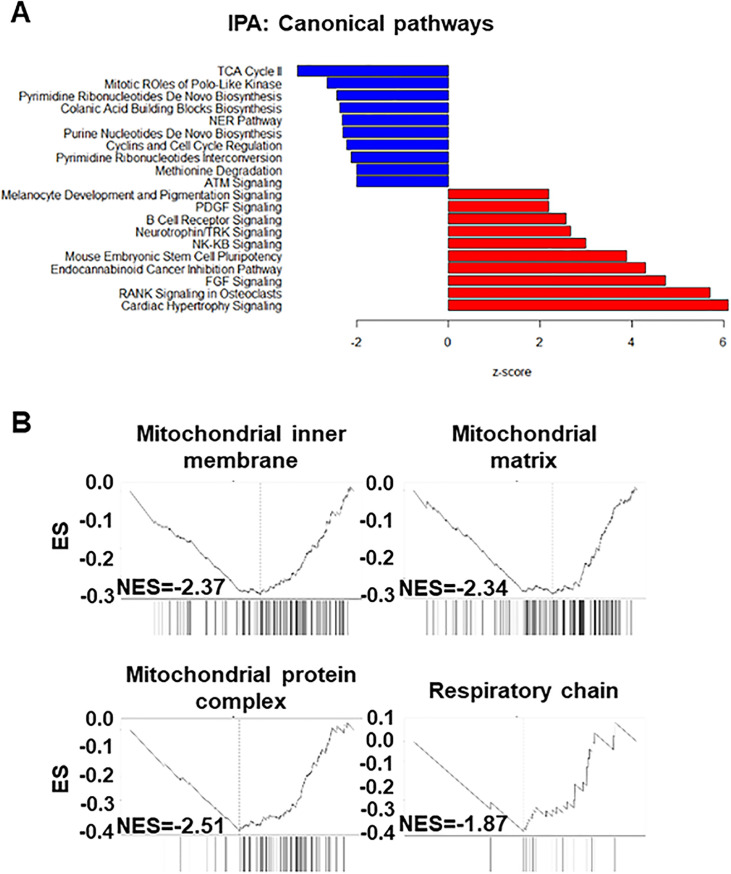
RNA-seq data indicate that EtOH may alter mitochondria-associated gene expression.EPC1, EPC2 and EPC3 cells were treated with or without EtOH (2%, 8 h) and subjected to RNA-Seq and data analysis. A. Bar diagram of canonical pathways significantly dysregulated by EtOH (p<0.01, z<-2 and >2). B. GSEA suggested negative enrichment of mitochondria-associated gene sets. ES, Enrichment score; NES, Normalized enrichment score.